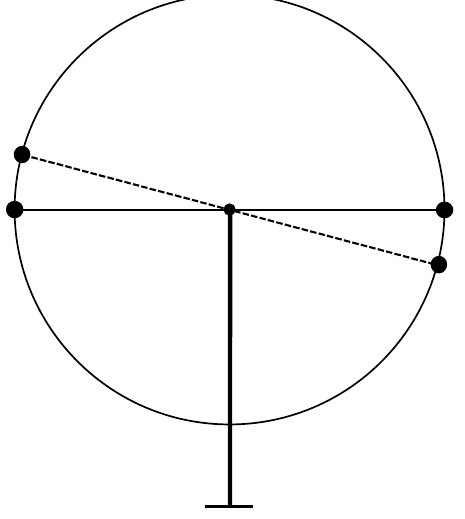
Figure 5. Circular motion of an equal-arm balance.